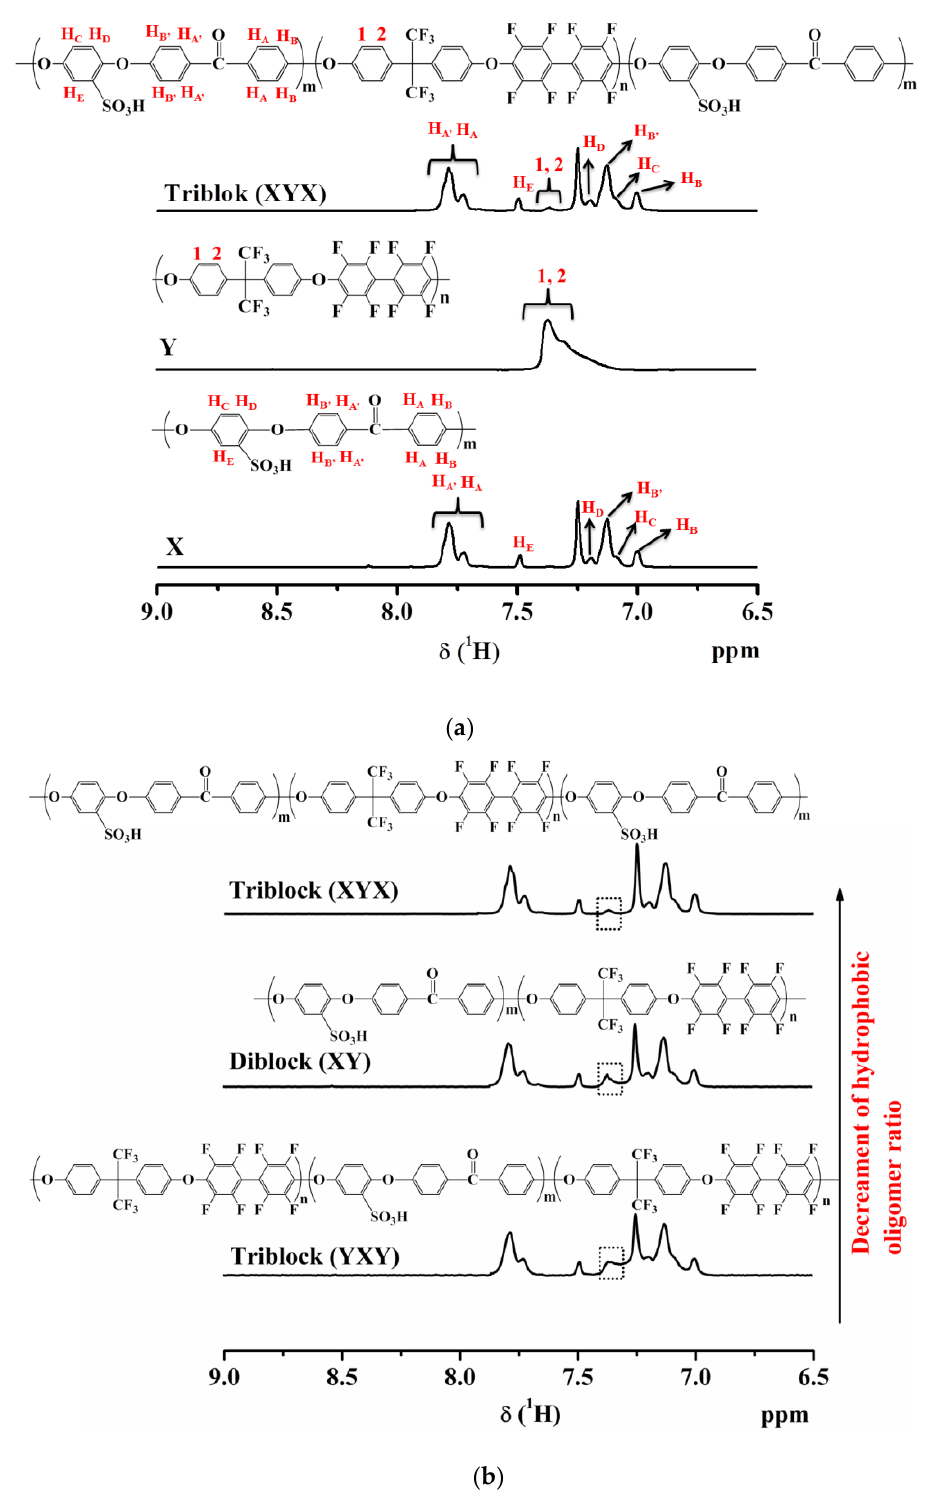
Figure 2. ( a ) 1 H-NMR spectra of X, Y and XYX. ( b ) 1 H-NMR spectra of block copolymers. Table 1. GPC analysis of prepared polymers Polymer